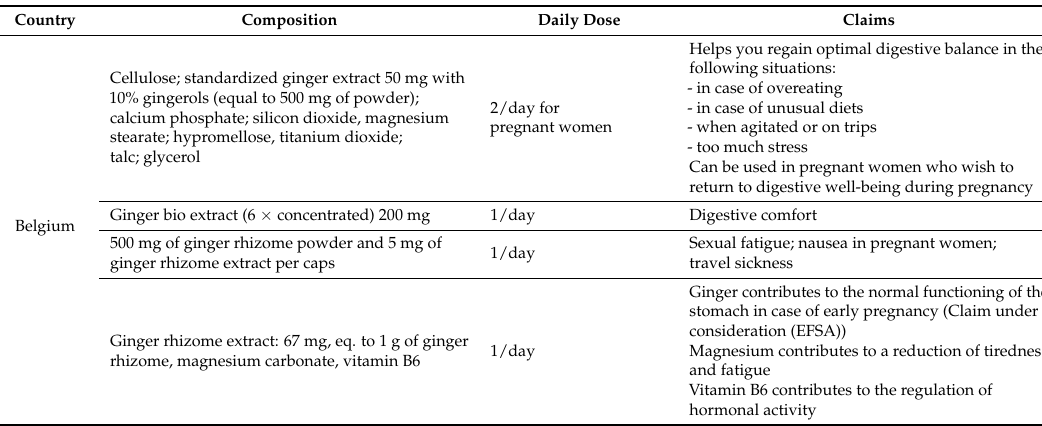
Table 2. Sample of food supplements with ginger sold around the world; composition and claims. Country